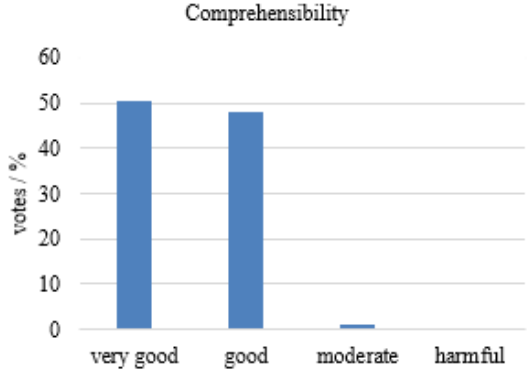
Fig. 10. Result of query in student-guided tutorial (single choice, N=79):